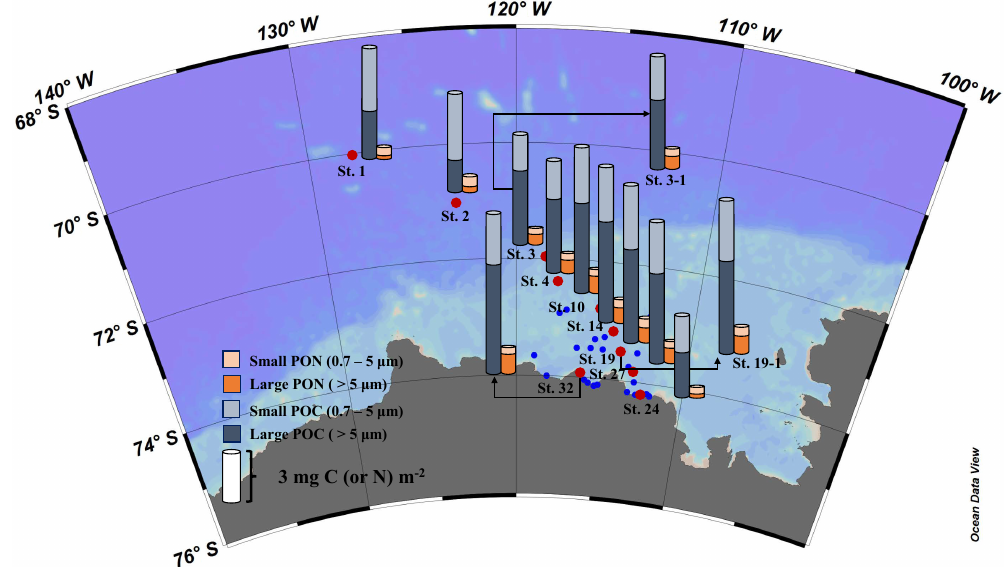
Figure 3. Water-column-integrated concentrations of POC (mgCm − 2 ) and PON (mgNm − 2 ) of small (0.7–5µm) and large (>5µm) phy- toplankton.